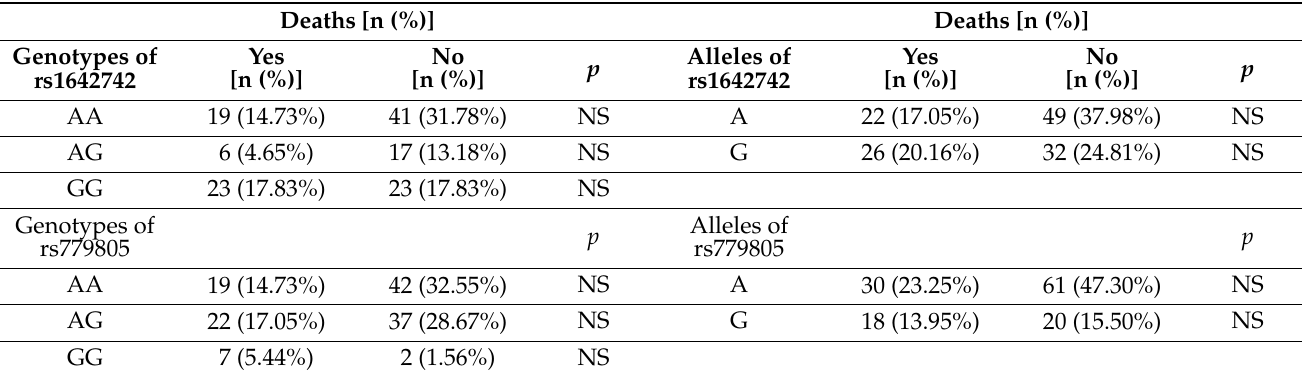
Table 7. Polymorphisms of VHL and patients’